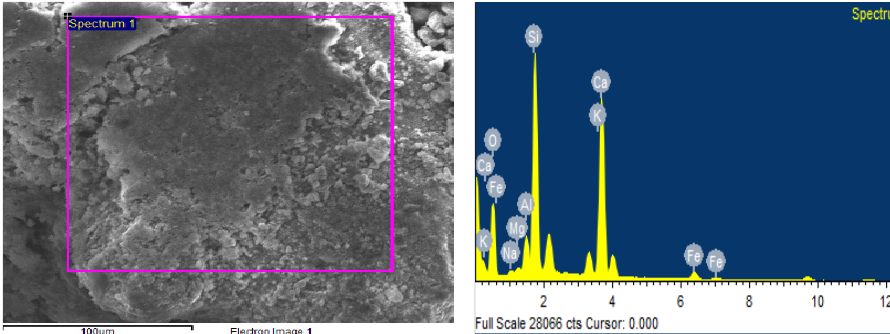
Figure 9. EDS of cement plain mortar. Figure 10. EDS of cem+bio mortar. Table 3. EDS analysis of cement-based mortars with and without biostabiliser.